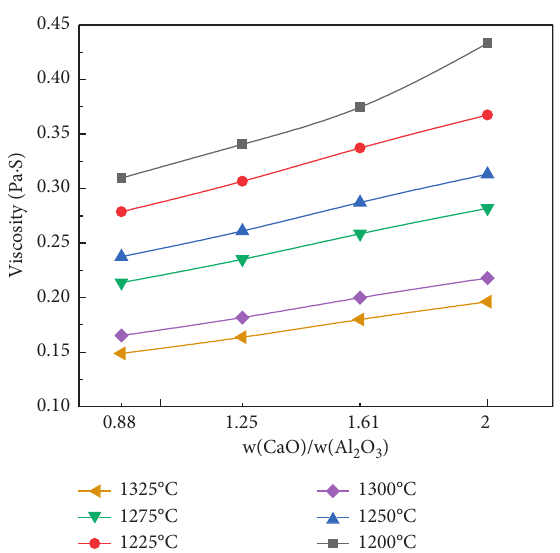
Figure 6: Viscosity of mold fluxes versus CaO/Al different